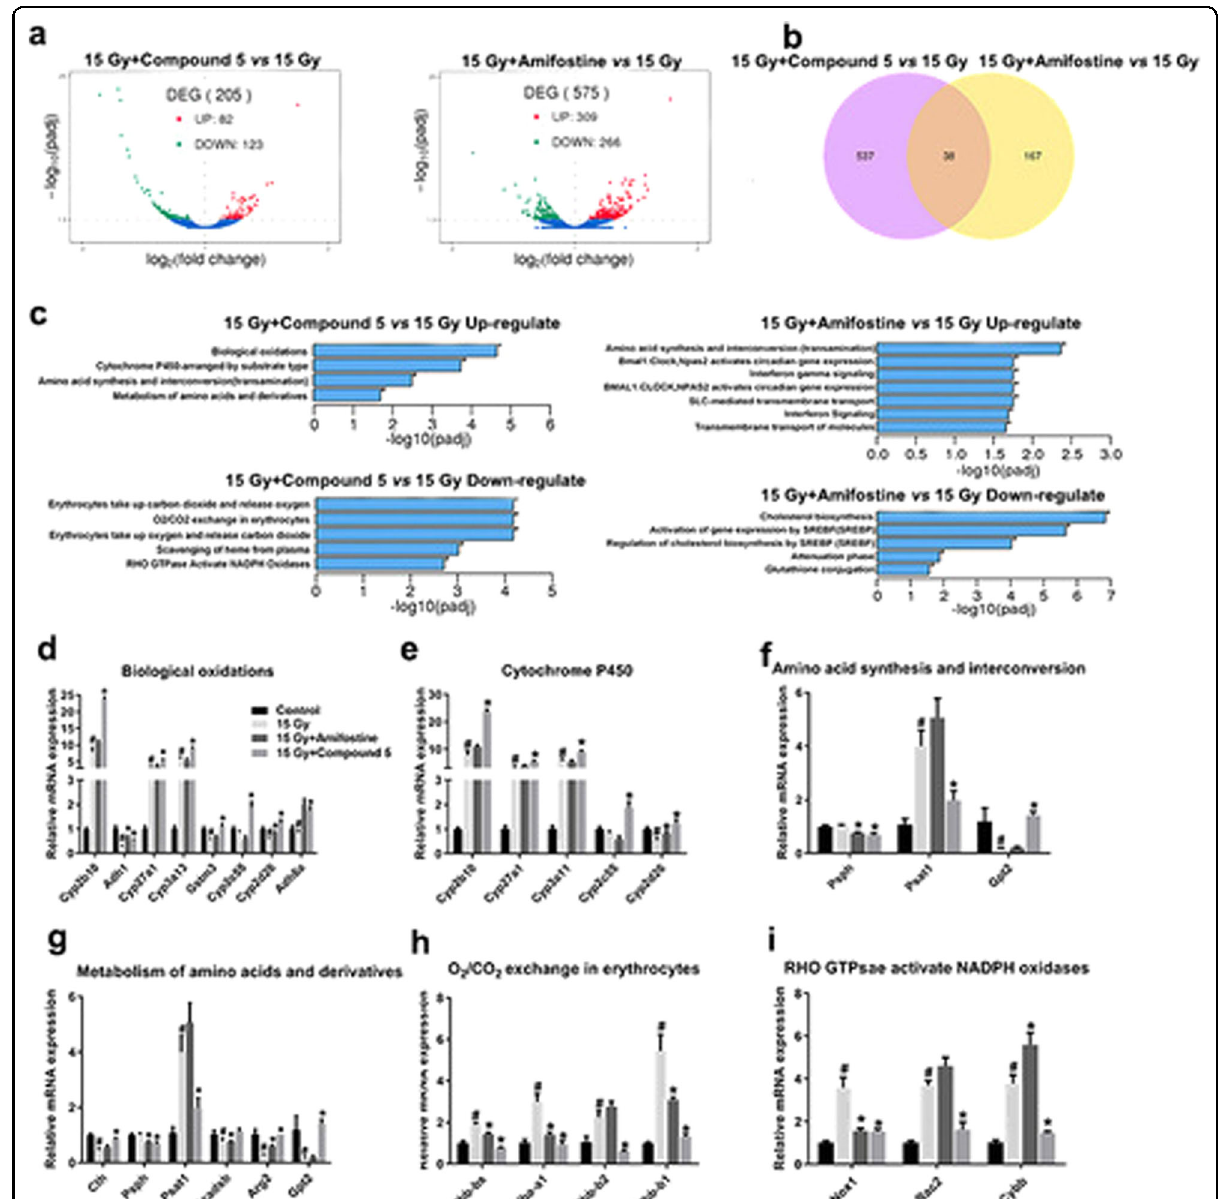
Fig. 7 Compound 5 regulates redox balance and amino acid synthesis and metabolism pathways in irradiated mice SI. Mice were administered with NS, compound 5 , and amifostine 20 min before exposure to 15 Gy ABI as described in the “ Materials and methods ” section; SI crypt was obtained 4 h after ABI. a Volcano plots show the number of regulated genes in intestine crypt after the irradiated mice were treated with compound 5 or amifostine; b Venn image shows the overlap genes regulated by both compound 5 and amifostine; c KEGG pathway analysis shows that compound 5 and amifostine regulate the different pathways; d – i realtime PCR results show the expression of genes involved in d biological oxidations, e cytochrome P450, f amino synthesis and interconversion, g metabolism of amino acids and derivatives, h O 2 /CO 2 exchange in erythrocytes, and i RHO GTPase active NADPH oxidases pathways; # p < 0.05 vs Control, * p < 0.05 vs 15 Gy, N = 3 in a – c , N = 4 in d – i